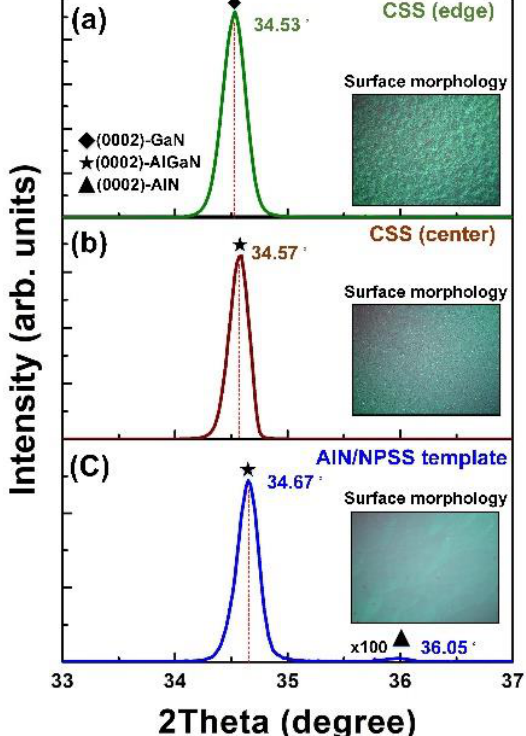
Figure 2. The typical XRD scan patterns of the AlGaN grown on ( a ) CSS (edge); ( b ) CSS (center); and ( c ) AlN/NPSS templates.